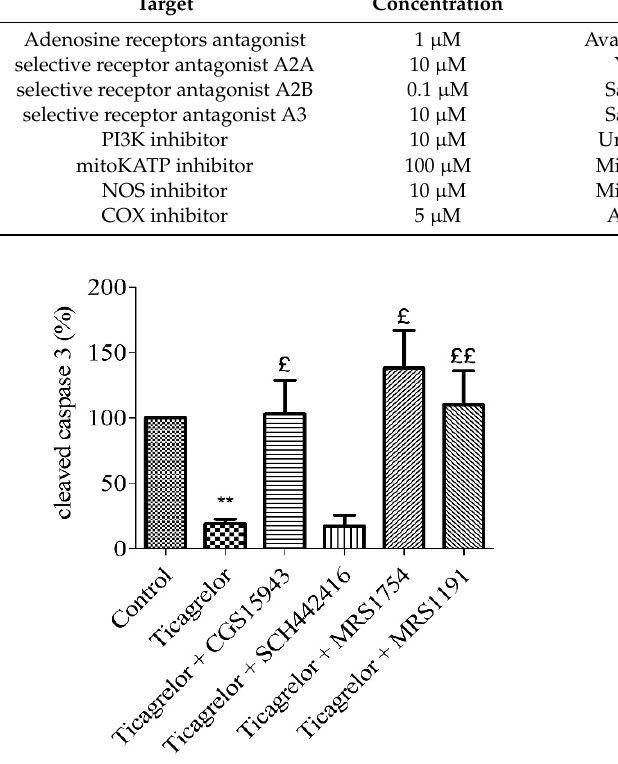
Figure 5. Anti-apoptotic effect of ticagrelor mediated by adenosine receptors. Five minutes prior to 10 µM ticagrelor treatment, HUVECs were treated with different adenosine antagonists. Thirty minutes after ticagrelor treatment, cells were exposed to simulated hypoxia for 2 h. The involvement